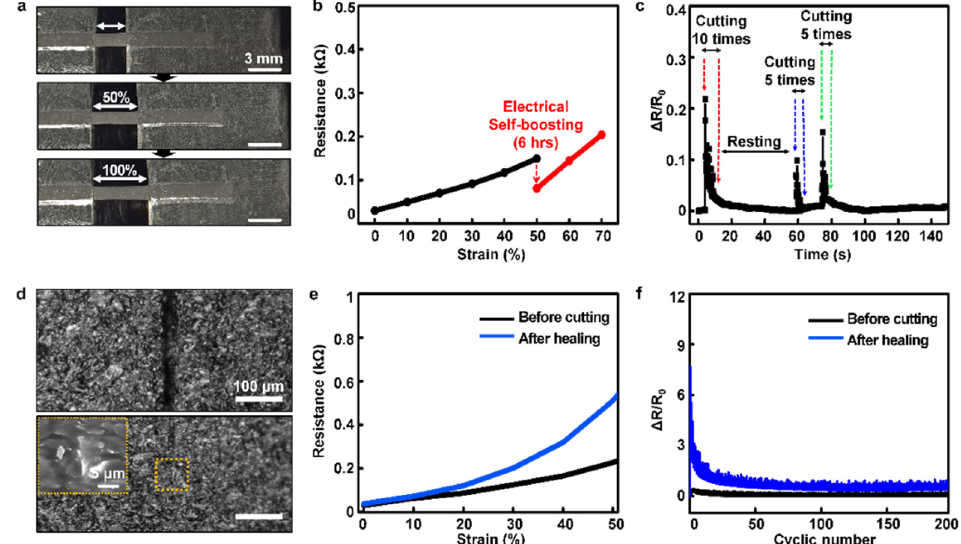
Figure 3. Characteristics of optimized conductive composites: ( a ) Photographs of optimized SHP–graphene composite conductor stretched up to 100% strain. ( b ) Resistance–strain data of the composite showing electrical self-boosting properties at 50% strain. ( c ) Electrical recovery phenomenon of the composite after several times of cutting. ( d ) OM images of SHP–graphene composite before and after self-healing (24 h). (Inset: SEM image of the composite after self-healing.) ( e ) Resistance–strain graphs of the composites before cutting and after self-healing. ( f ) Repetitive stretching (strain of 50%, over 200 cycles) and releasing test of the composites before cutting and after